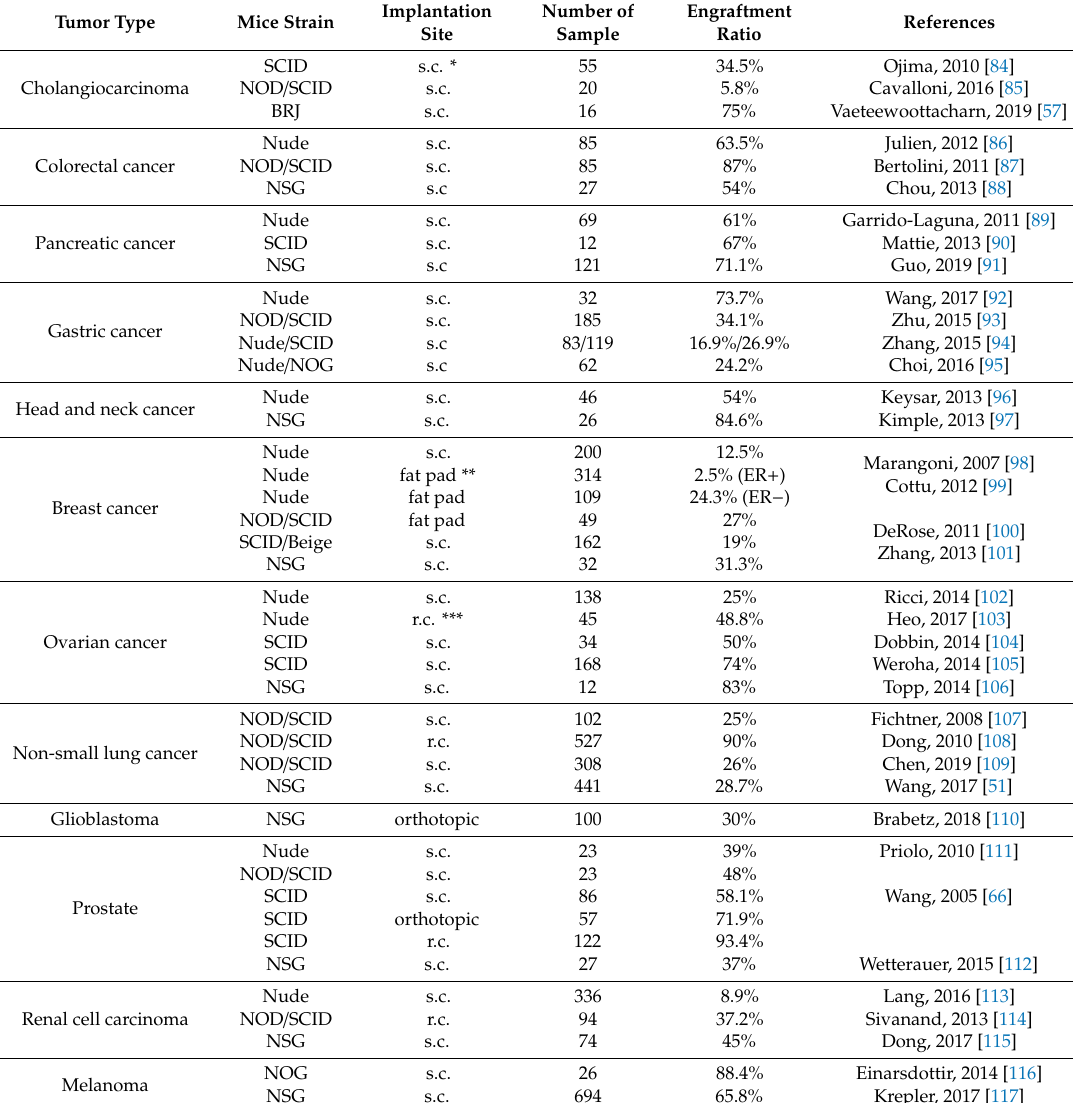
Table 5. PDX success rates in di ff erent immunocompromised